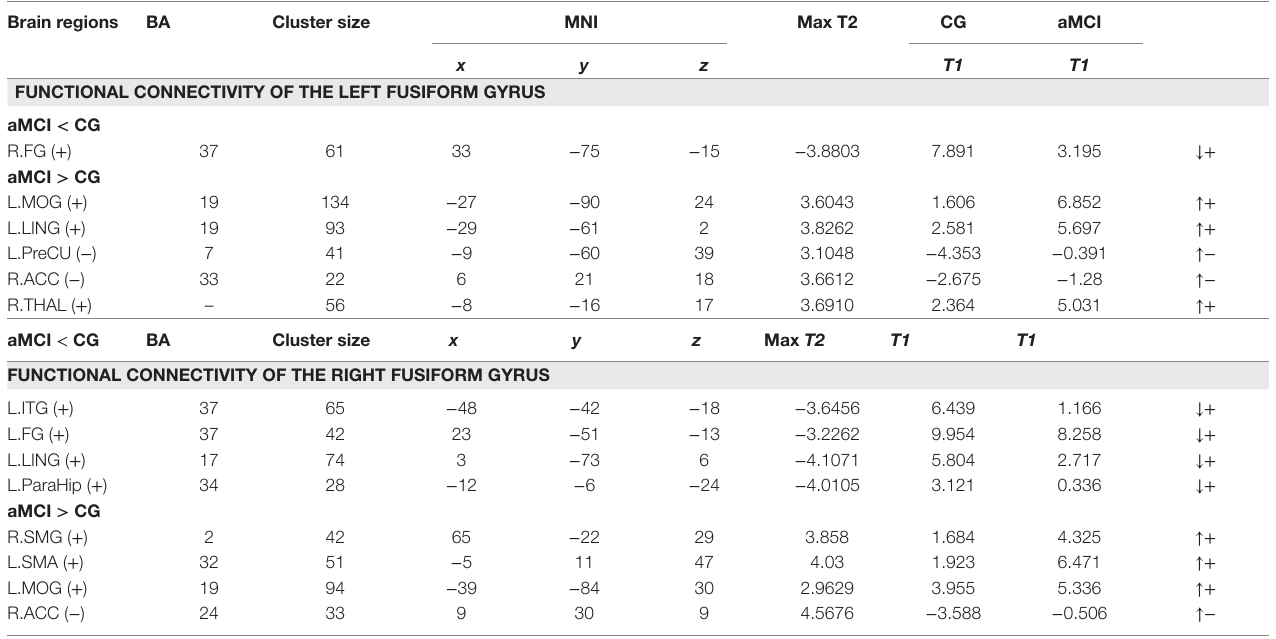
TaBle 3 | regions showing functional connectivity differences of the left/right fusiform gyrus between the aMci and control group ( P < 0.01, 28 voxels, corrected for multiple comparisons). Brain regions